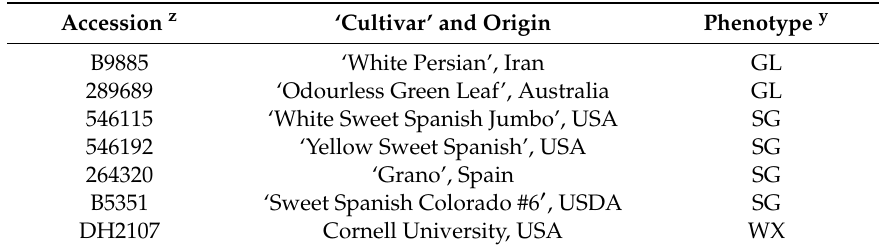
Table 1. Origins and visual foliar phenotypes of accessions evaluated for epicuticular waxes by gas chromatography and spectroscopy.